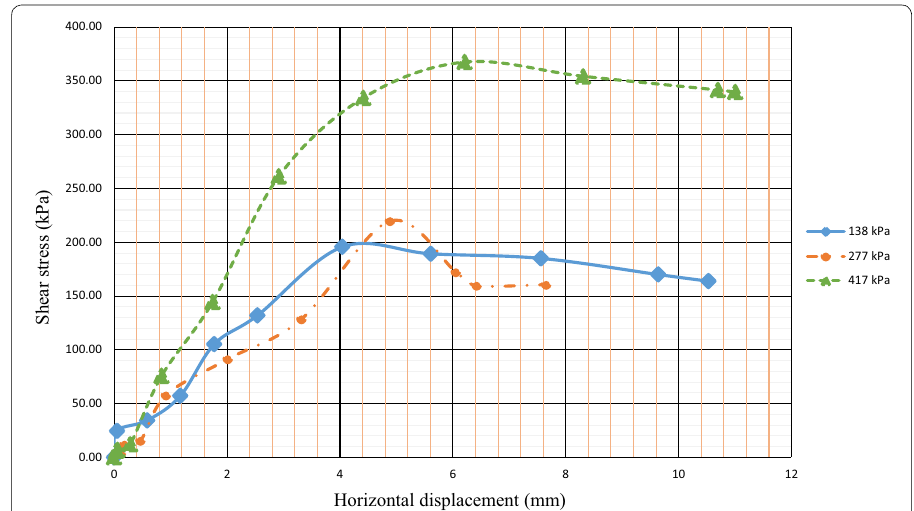
Fig. 7 Shear stress versus horizontal displacement curve for soil to concrete for specimen sample set 2